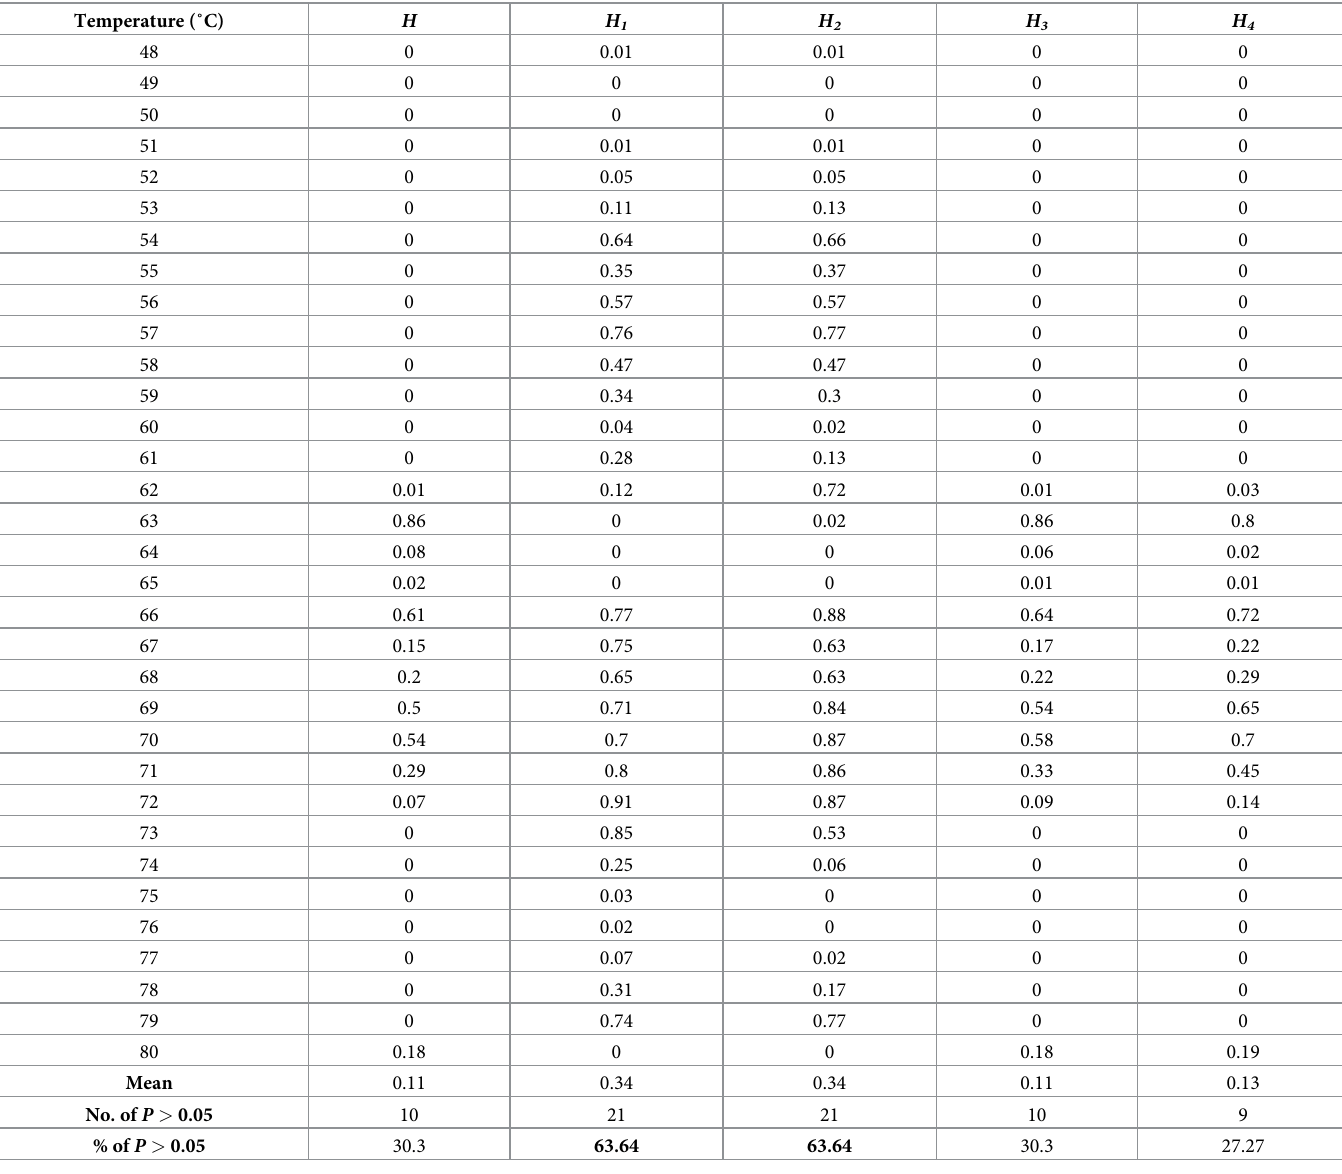
Table 2. Results of the normality test showing p-values at different temperature points using data transformations for three-group classification. Temperature